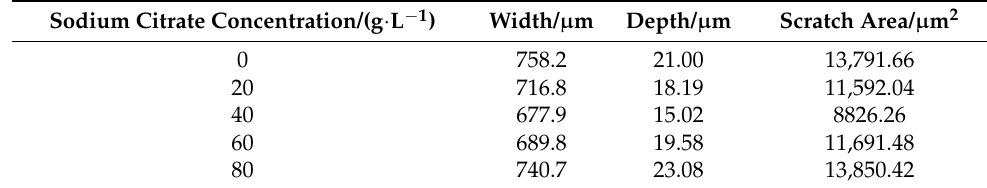
Table 4. Effect of sodium citrate concentration on wear mark section parameter of